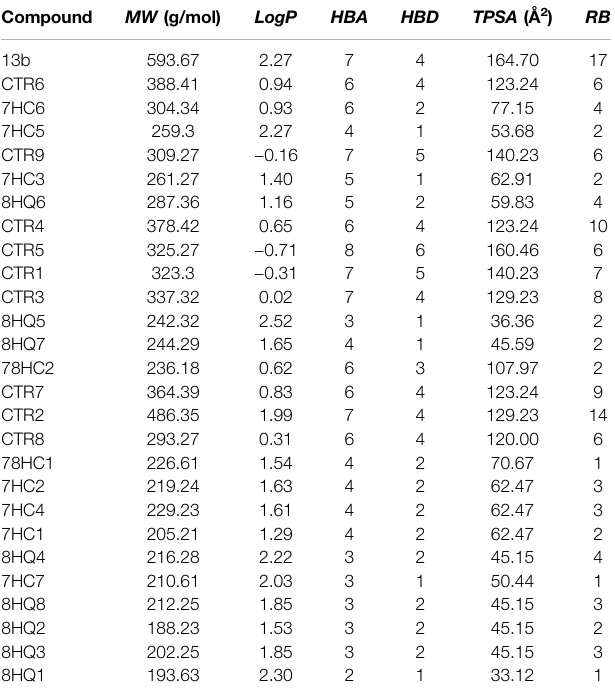
TABLE 4 | ADME molecular descriptors of compounds designed to inhibit SARS-CoV-2 M pro . Compound MW (g/mol) LogP